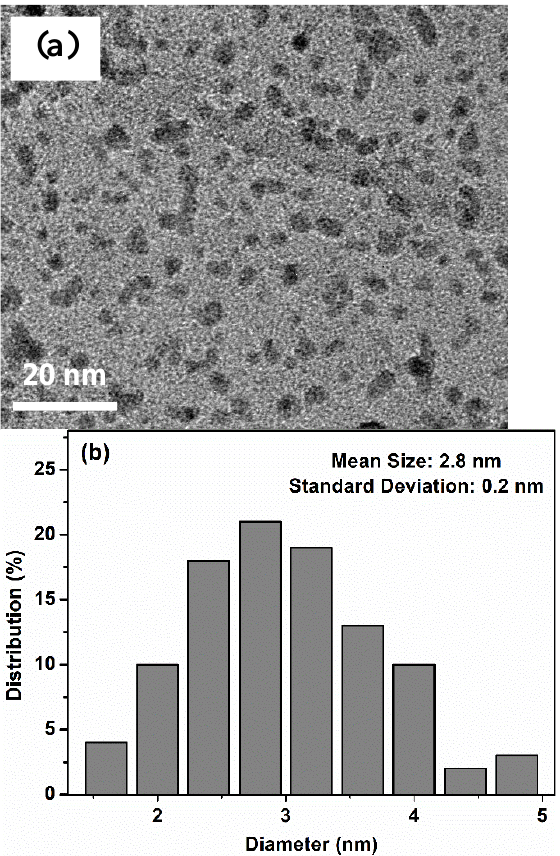
Figure 2. TEM image ( a ) and corresponding particle distribution plot ( b ) of Pd/NAC catalyst.